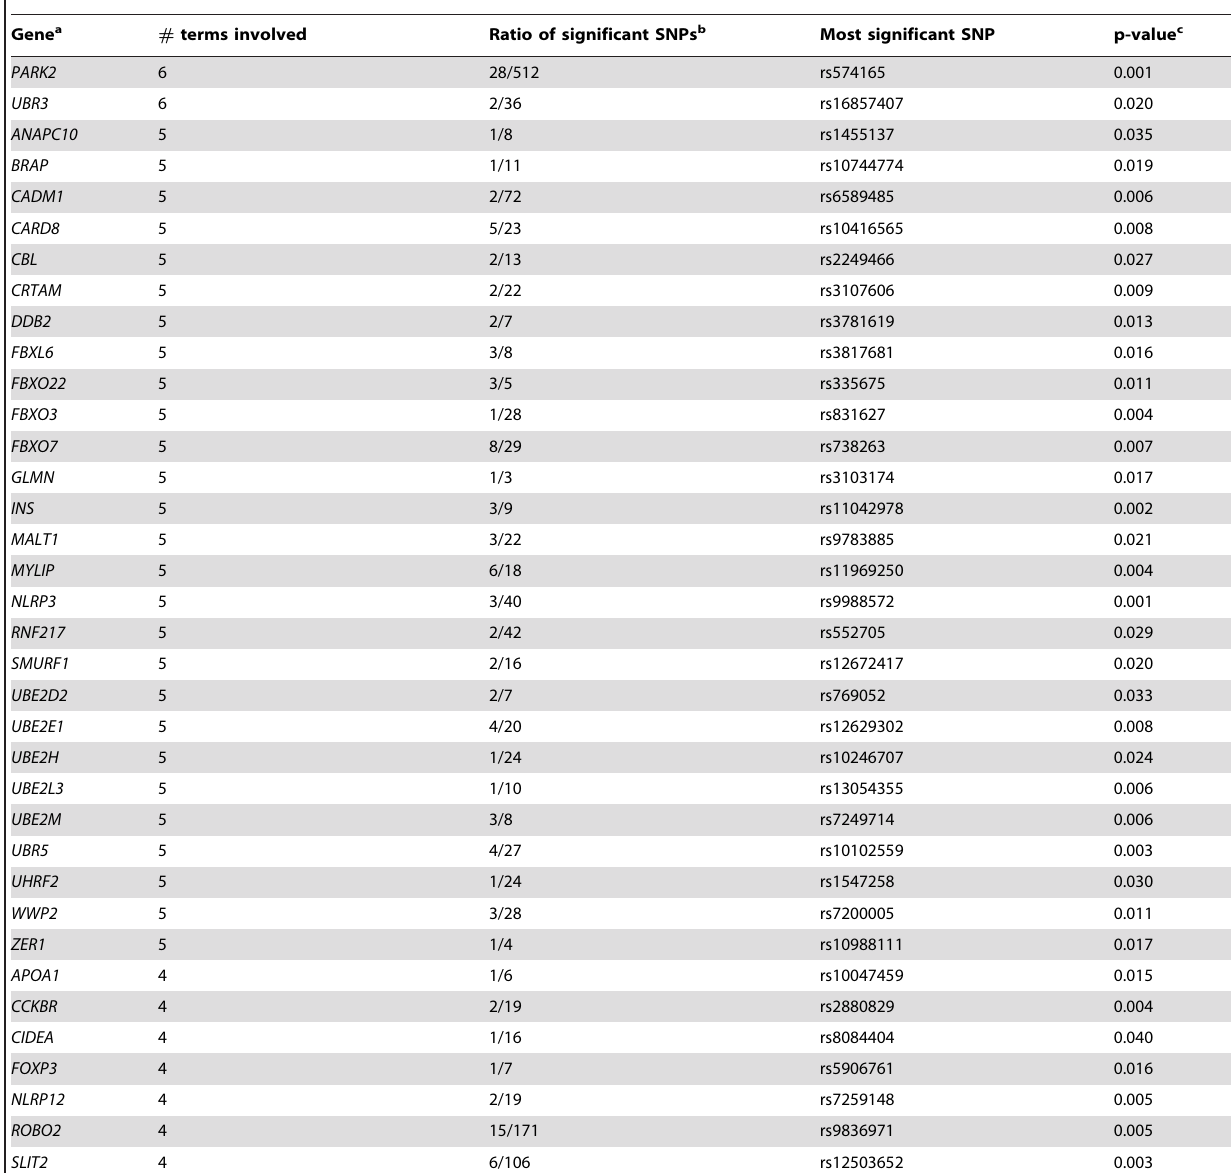
Table 3. Enriched genes in the 30 top Gene Ontology (GO) terms.